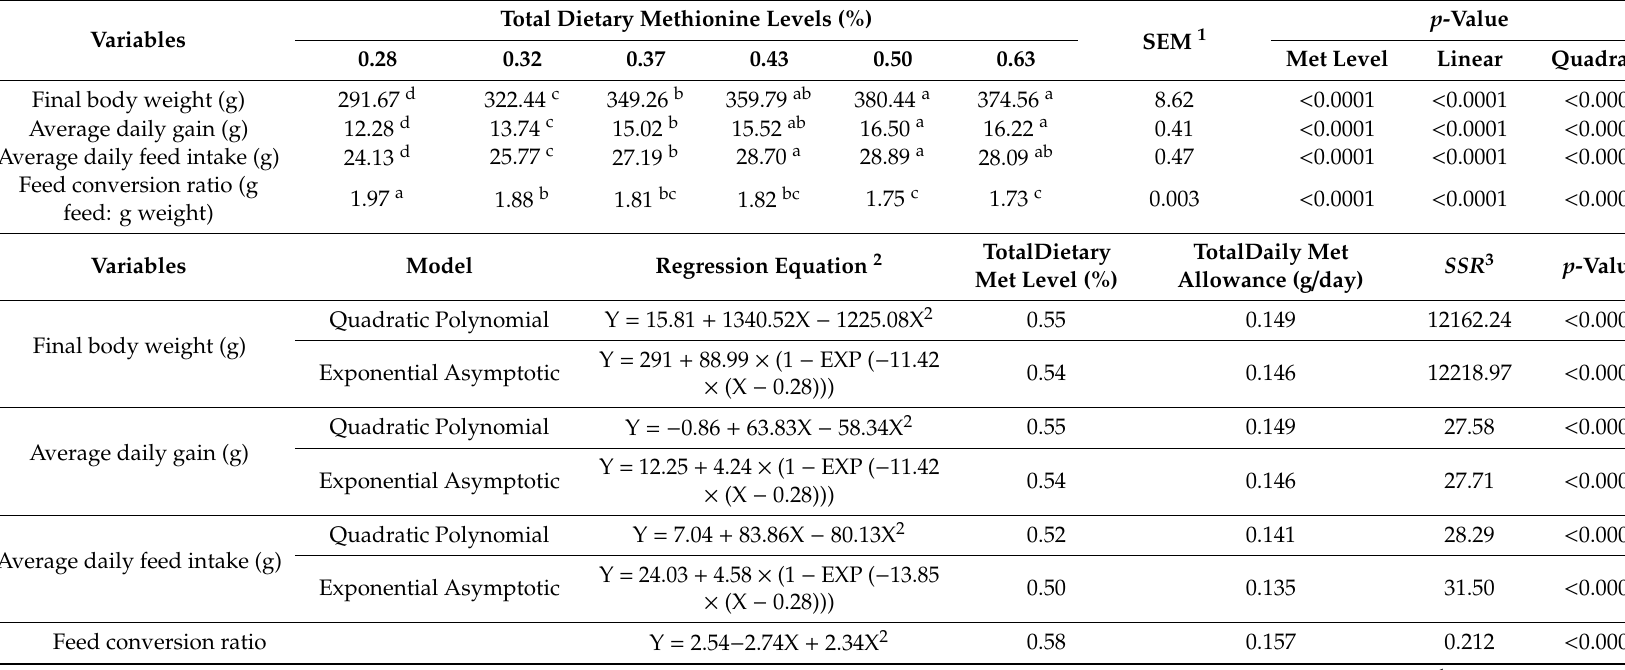
Table 2. E ff ects of total dietary methionine level on growth performance of male Lingnan yellow-feathered chickens aged 1–21 days. Variables